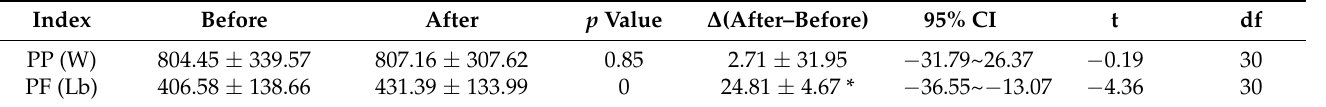
Table 3. The information of PP and PF between before and after − 5 ◦ C cryotherapy. (Mean ±